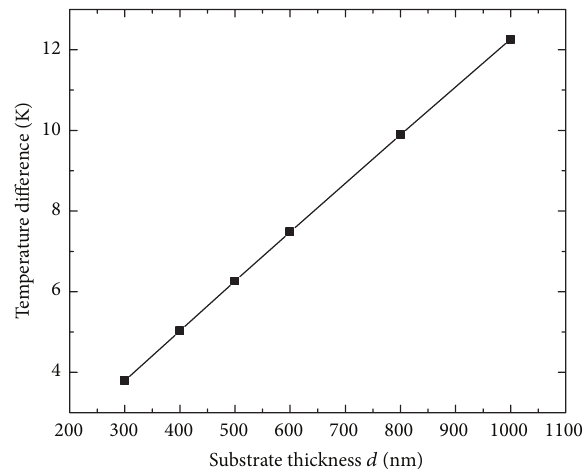
Figure 7: Relationship between substrate thickness and surface temperature